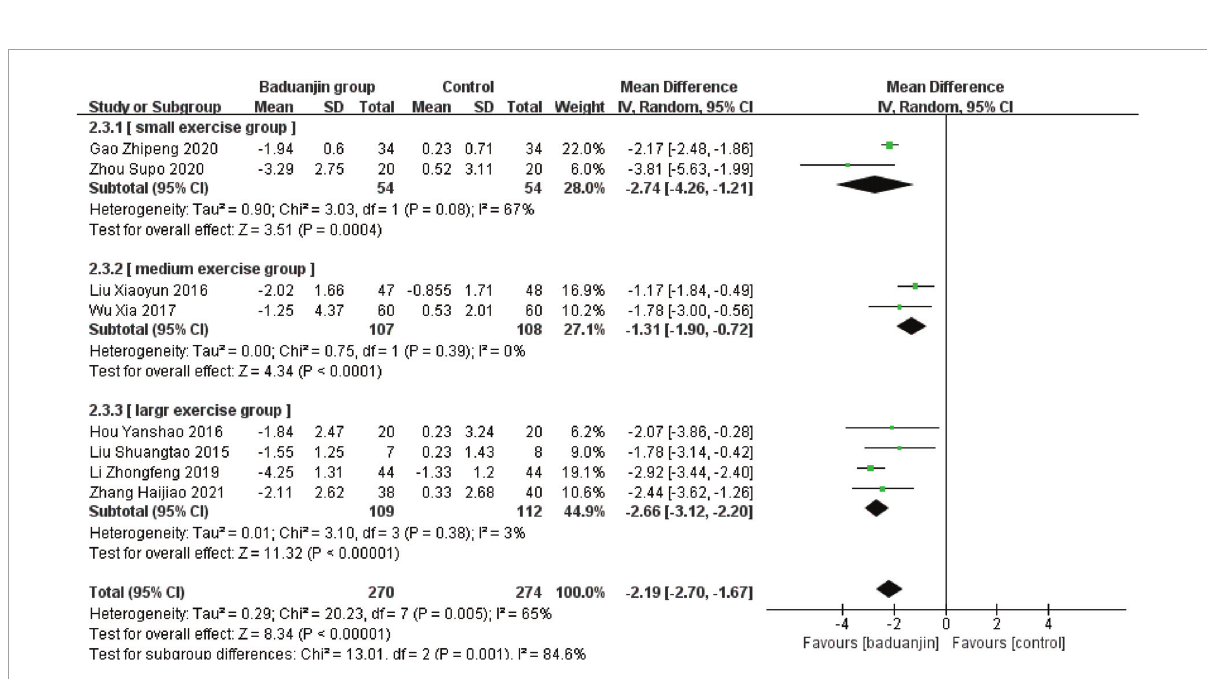
FIGURE10 Forest plot of the subgroup analysis of TUG for the total exercise amount. CI, confidence interval; SD, standard deviation.